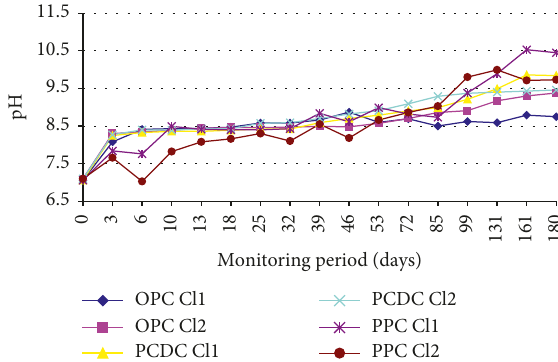
Figure 8: pH measurements in simulated chloride